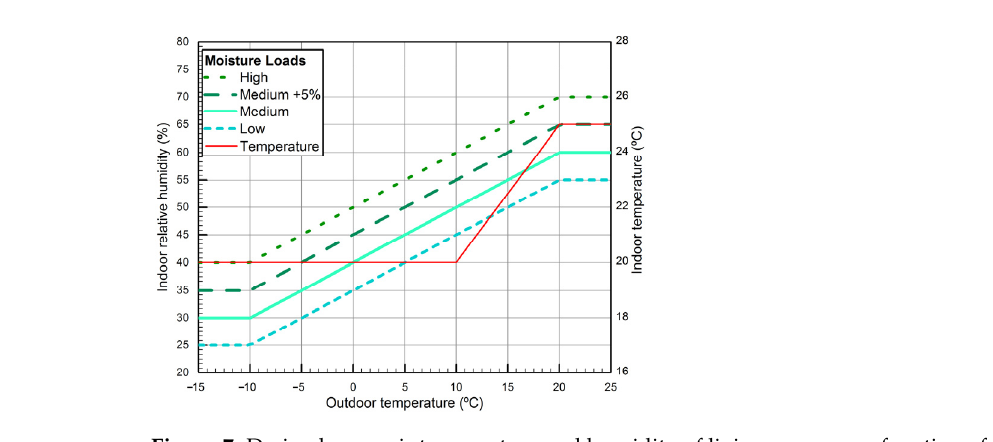
Figure 6. External and internal environmental conditions for the simulation model: ( A ) temperature and humidity, ( B ) solar radiation, ( C ) precipitation, and ( D ) wall radiation and wind-driven rain.